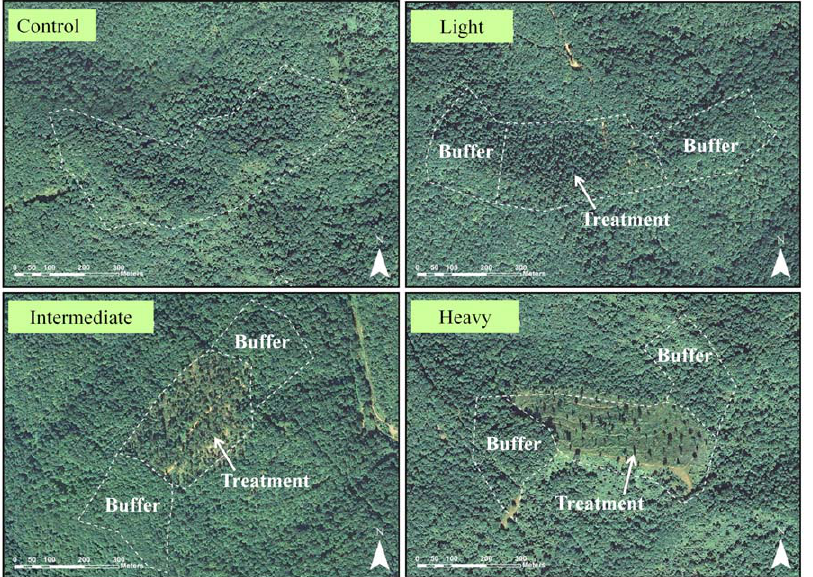
Figure 2. Aerial photos from a study site (LW) depicting treatment plot design and intensity of disturbances. Each field site consisted of three 10-ha treatment plots of various disturbance intensity (created via partial timber harvest) and one 20-ha control plot (undisturbed). Ten ha of undisturbed forest outside the borders of each treatment plot (buffers) allowed for examination of edge effects of the disturbances.